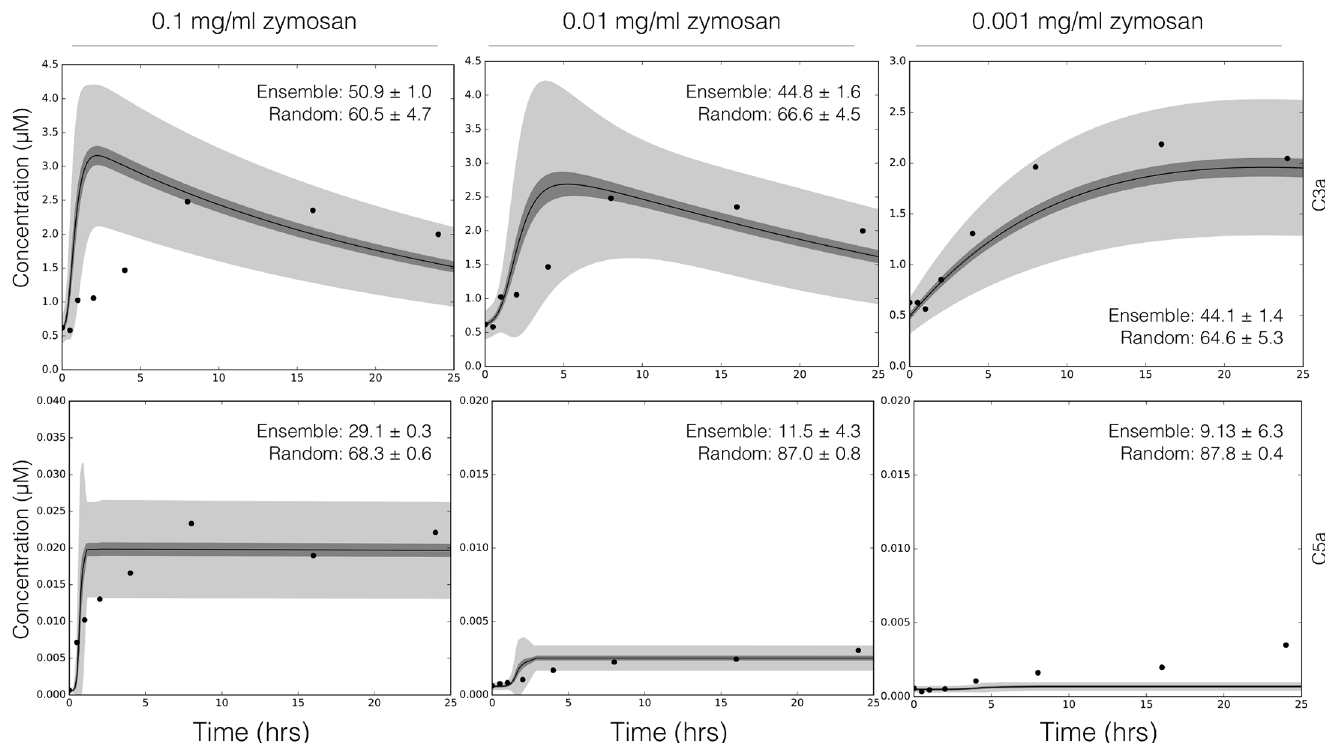
Fig 3. Reduced order complement model predictions. Simulations of C3a and C5a generated using 0.1 mg/ml, 0.01 mg/ml, and 0.001 mg/ml zymosan were comparedwith the correspondingexperimental measurements. The solid black lines show the simulatedmean value of C3a or C5a for the ensemble,whilethe dark shadedregiondenotesthe 99% confidenceinterval of mean. The light shaded regiondenotesthe 99% confidenceinterval of the simulatedC3a and C5a concentration. The experimental validation data (points) was taken from Morad et al [35]. All initial conditionsnot specifiedby the experimental conditionwere assumed to be at zero or their physiological serum levels unless otherwisenoted (S1 Table).